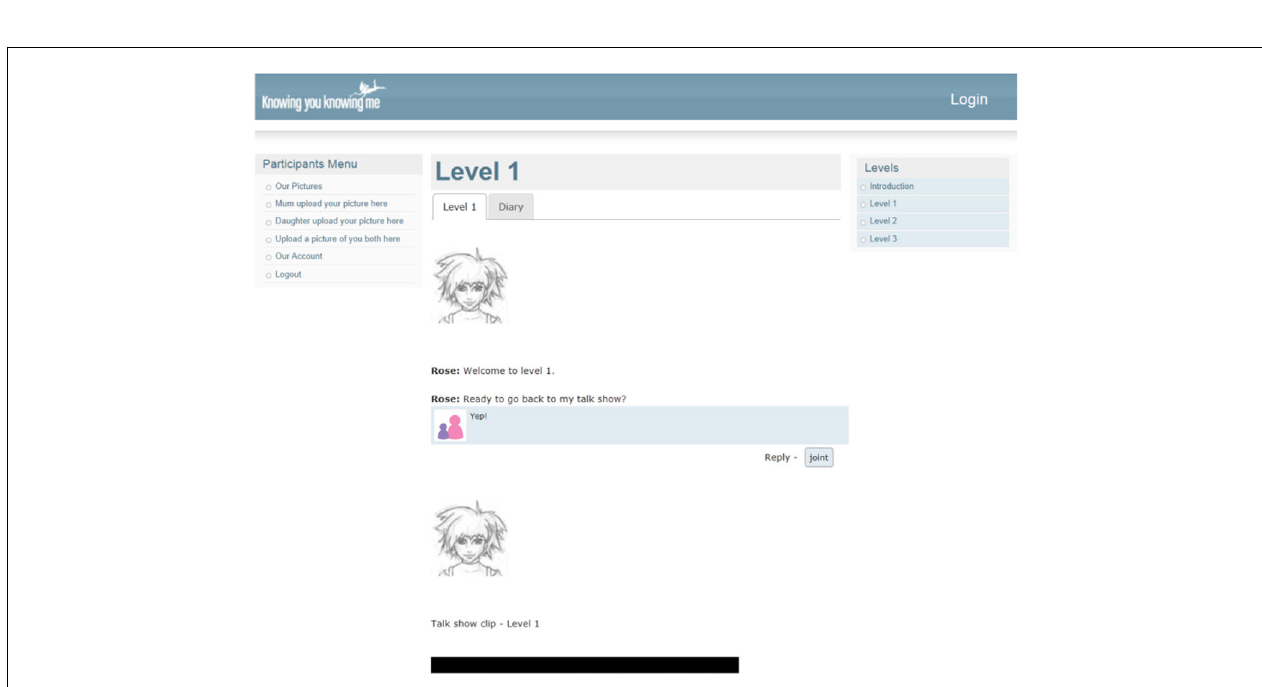
FIGURE 2 | Screenshot of Rose’s Knowing you, Knowing me, social media wall, with posts from mother and daughter participants.